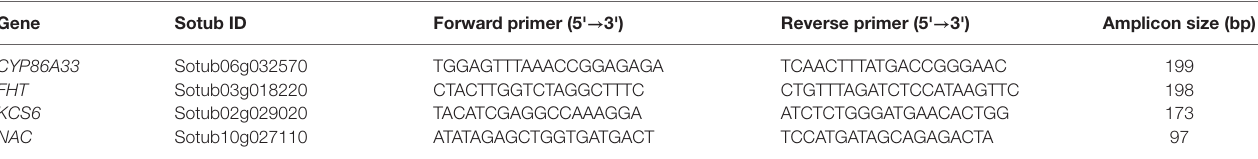
TaBlE 1 | Primers used in the